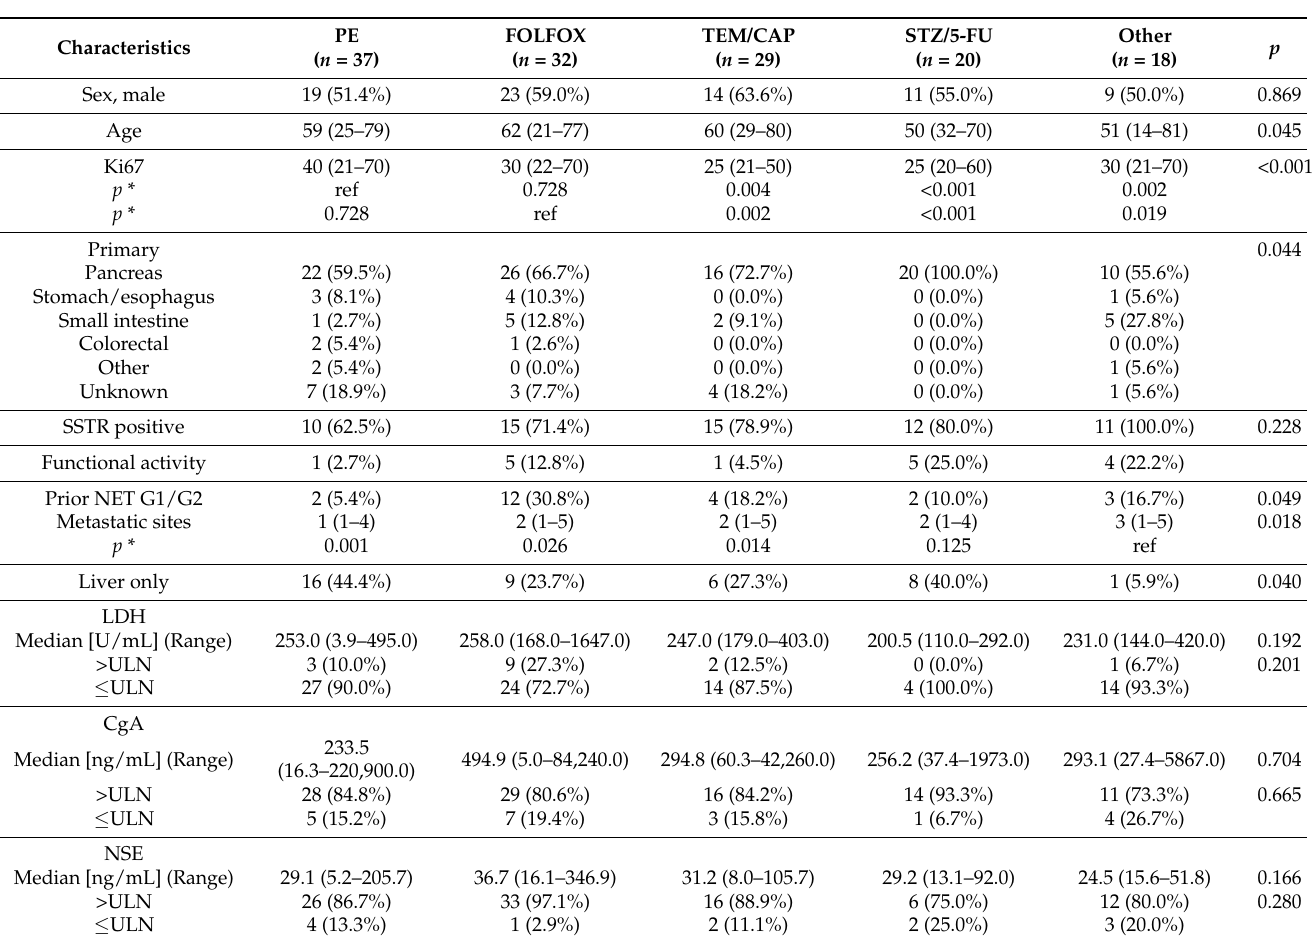
Table 3. Patient characteristics in different first-line treatment subgroups.